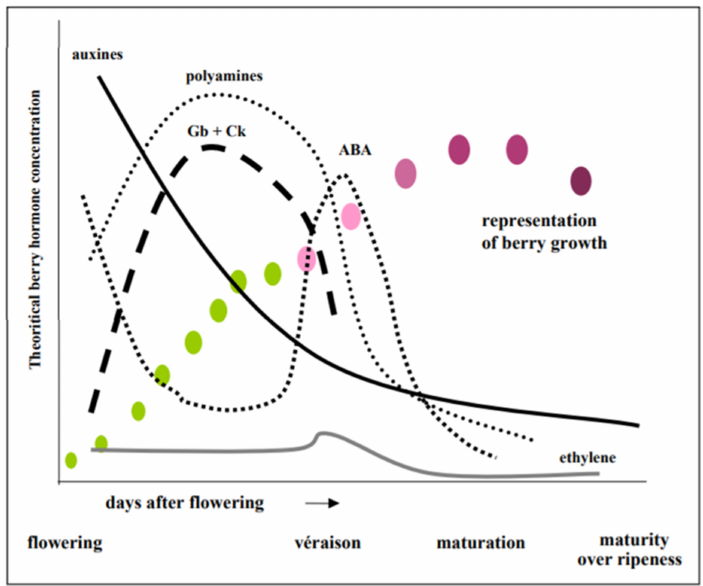
Figure 4. Theoretical evolution of plant hormones during berry development. Gb: gibberellines; Ck: cytokinins; ABA: abscissic acid